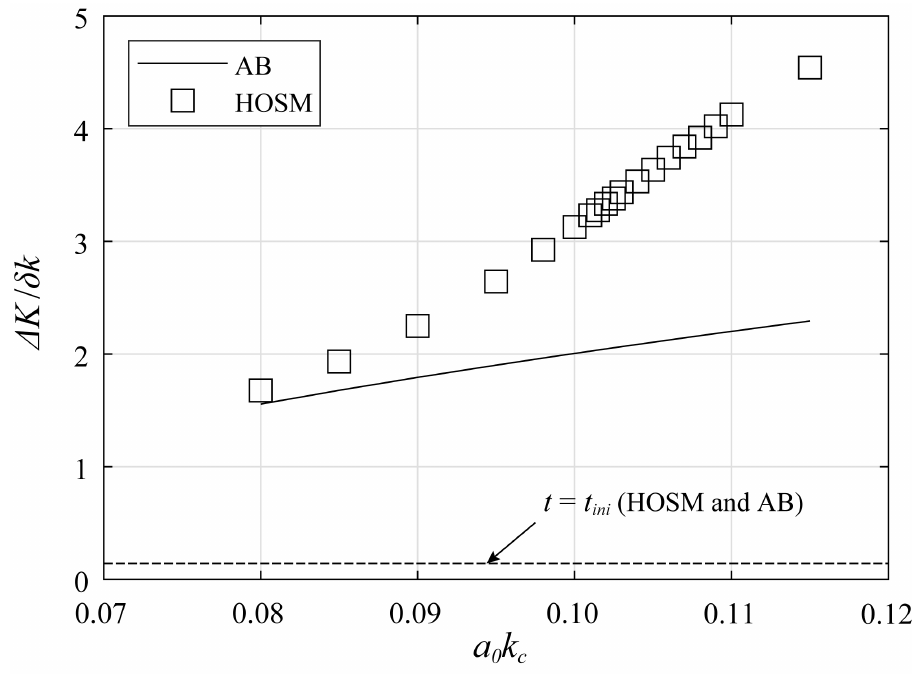
Figure 7. Relation between the initial wave steepness a 0 k c and mean wavenumber difference ∆ K / δ k at t = t max for the modulated wave train. The dashed line represents the initial